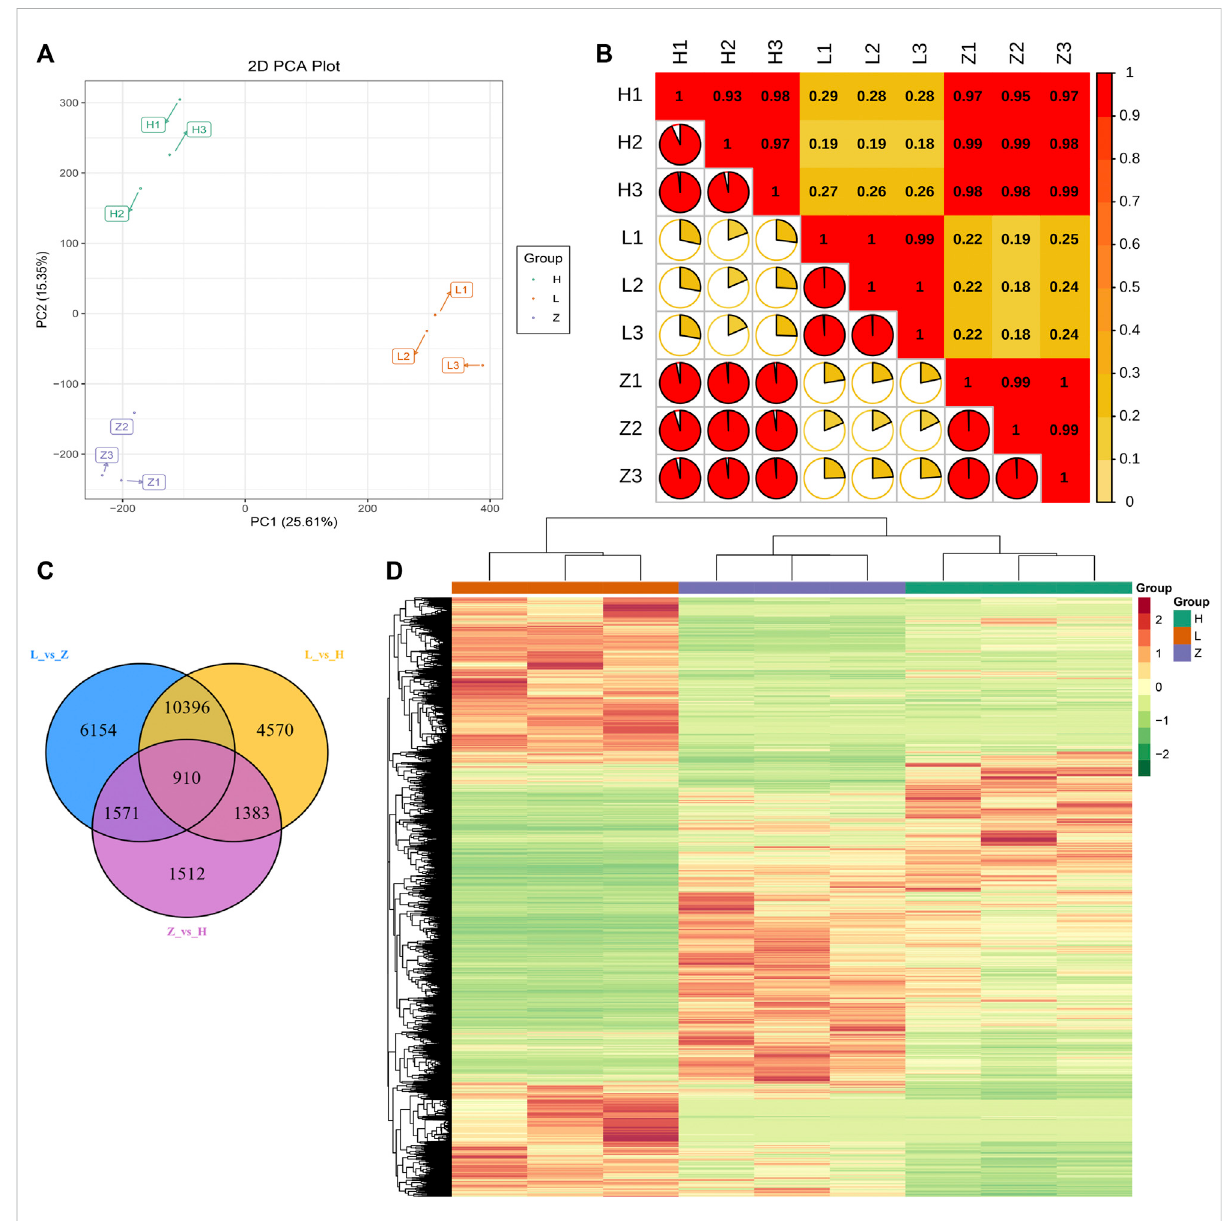
FIGURE 5 Transcriptome pro fi ling of three different colored leaves of C. ensifolium . (A) PCA plot based on FPKM values of all the quanti fi ed genes. (B) correlation plot of quanti fi ed genes. (C) venn diagram representing differentially expressed genes and their overlap in comparison between green, yellow, and purple leaves, viz., L vs. H, L vs. Z, and Z vs. H. (D) heatmap representing FPKM values of all the quanti fi ed genes through transcriptome pro fi